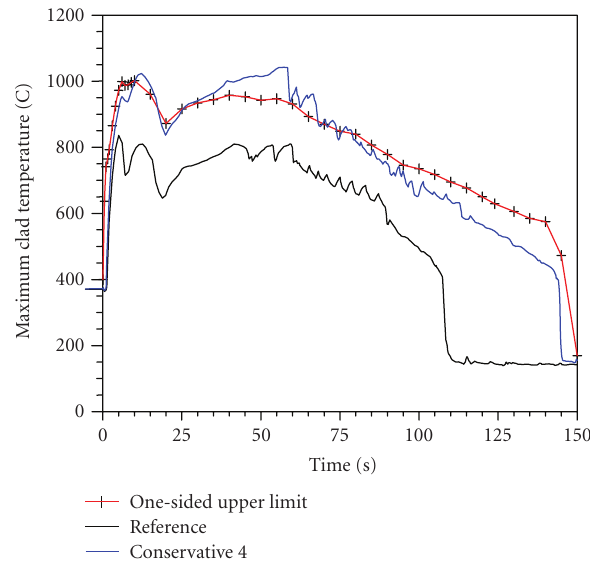
Figure 3: Calculated one-sided 95% / 95% uncertainty limit and best estimate reference calculation compared with a “conservative” calculation of rod clad temperature for a reference reactor during a postulated double ended o ff set shear cold leg